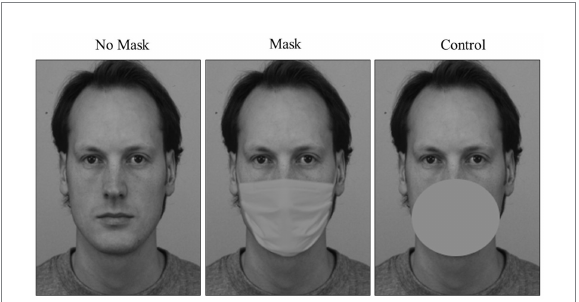
FIGURE 1 Example of the three conditions employed in the study: No Mask, Mask, and Control. Face stimuli were selected from the Karolinska Directed Emotional Faces database (KDEF; Lundqvist et al., 1998). The identity of the face depicted is AM10